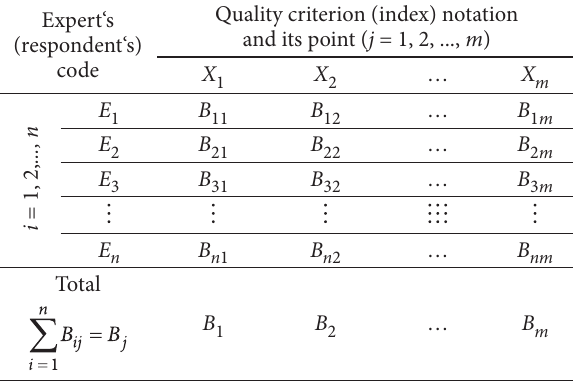
Table 1. Weight values given by experts to AMP quality indices in points B